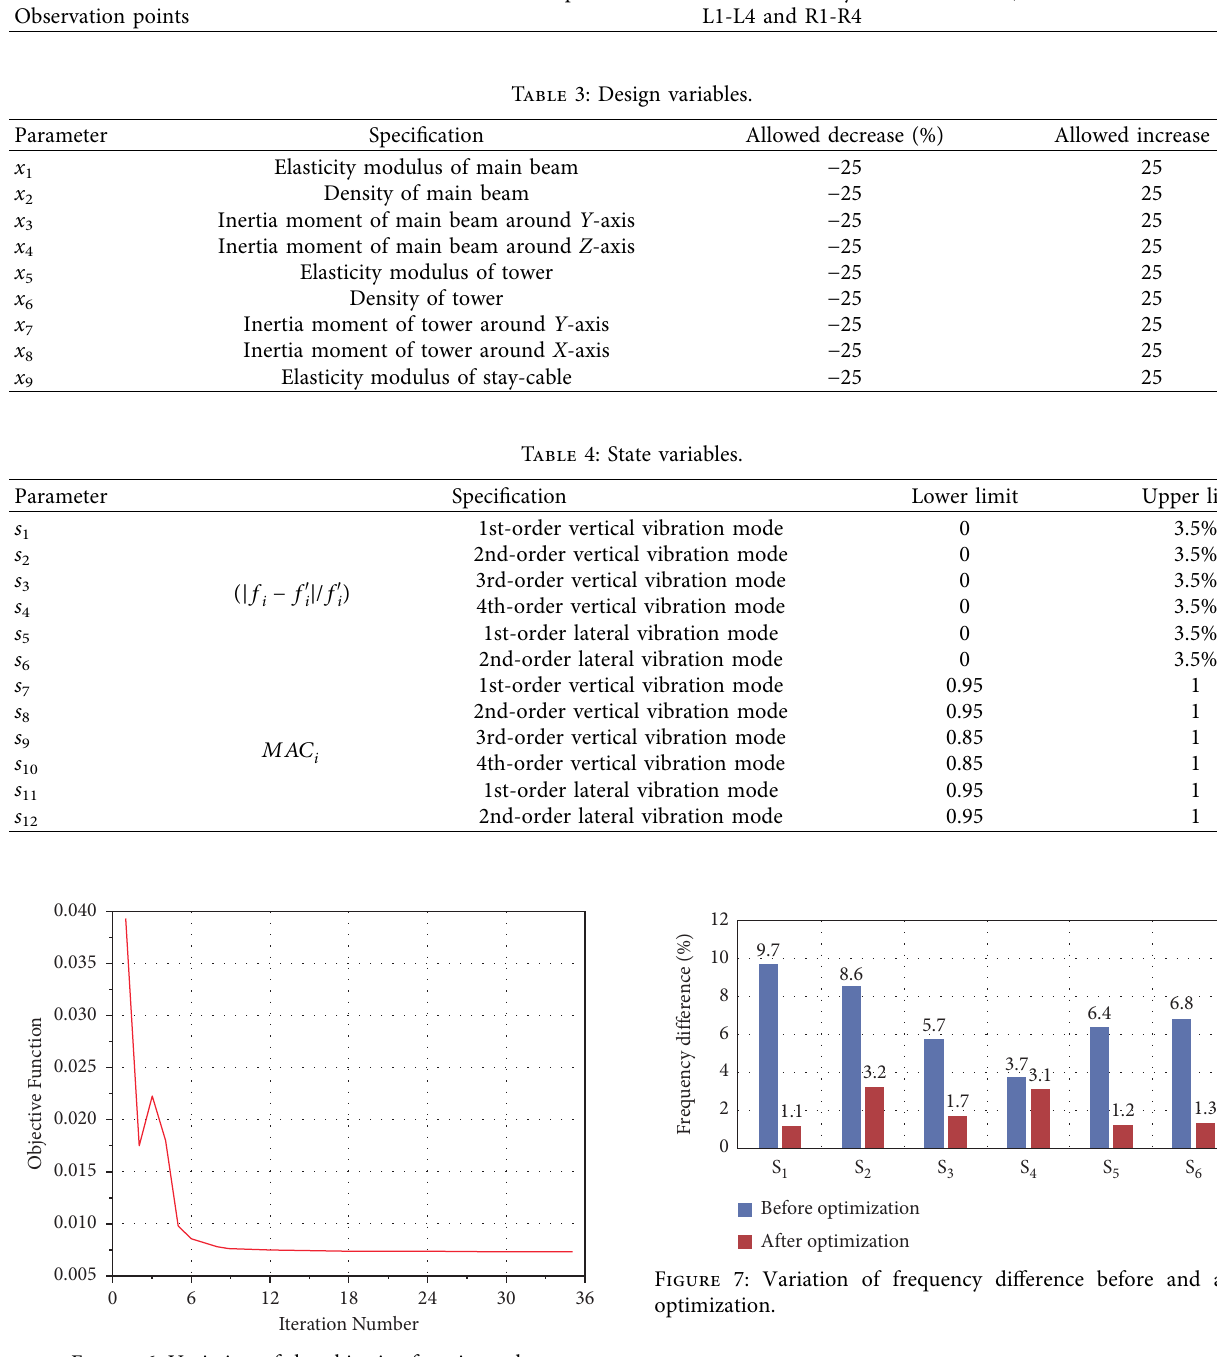
Figure 6: Variation of the objective function value.